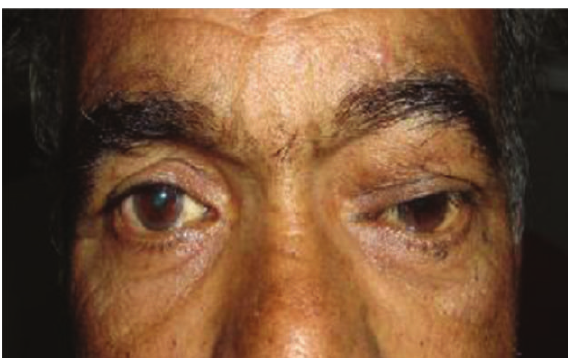
Figure 1: Clinical preoperative photograph of patient with upper lid mass and eccentric proptosis.